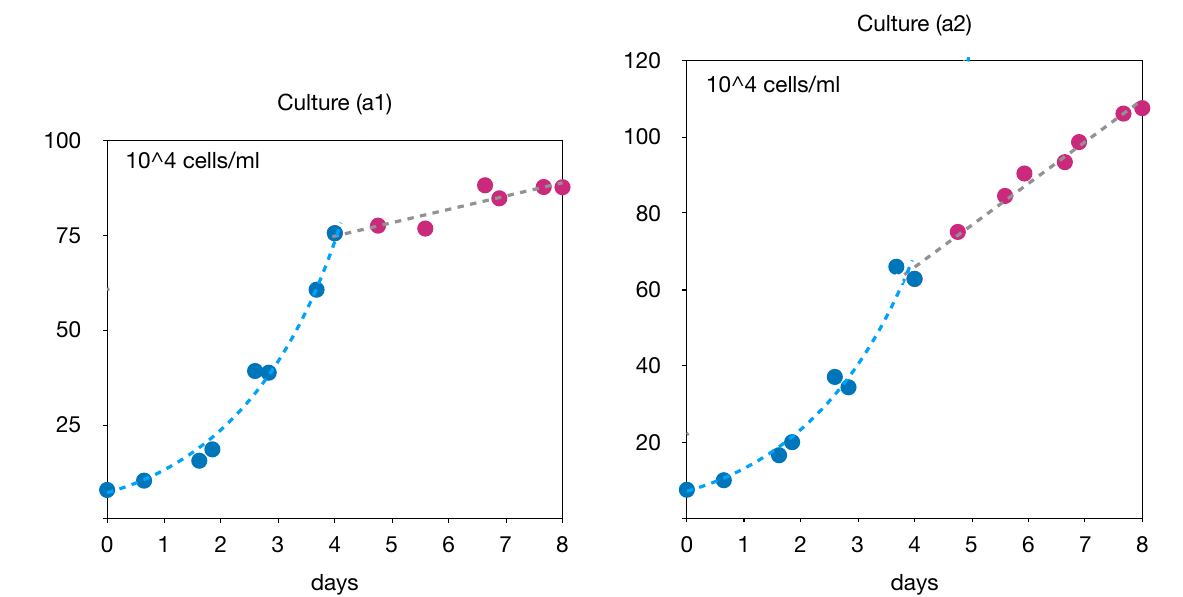
Figure 1. Time evolution of cell density in cultures a1 ( left ) and a2 ( right ).